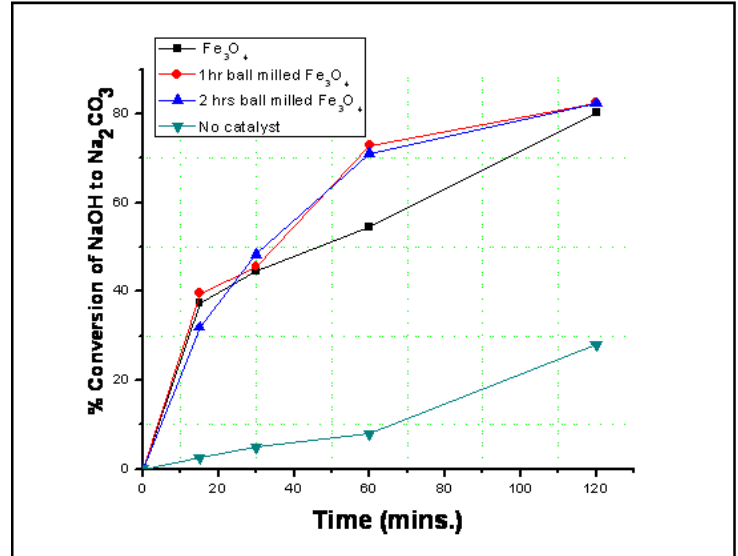
Figure 6. % Conversion of NaOH to Na 300 °C. 1 and 2 h Ball milling time has exhibited comparable